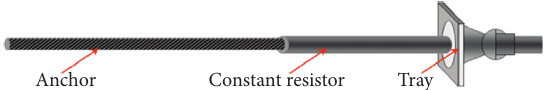
Figure 8: Structure schematic diagram of the NPR